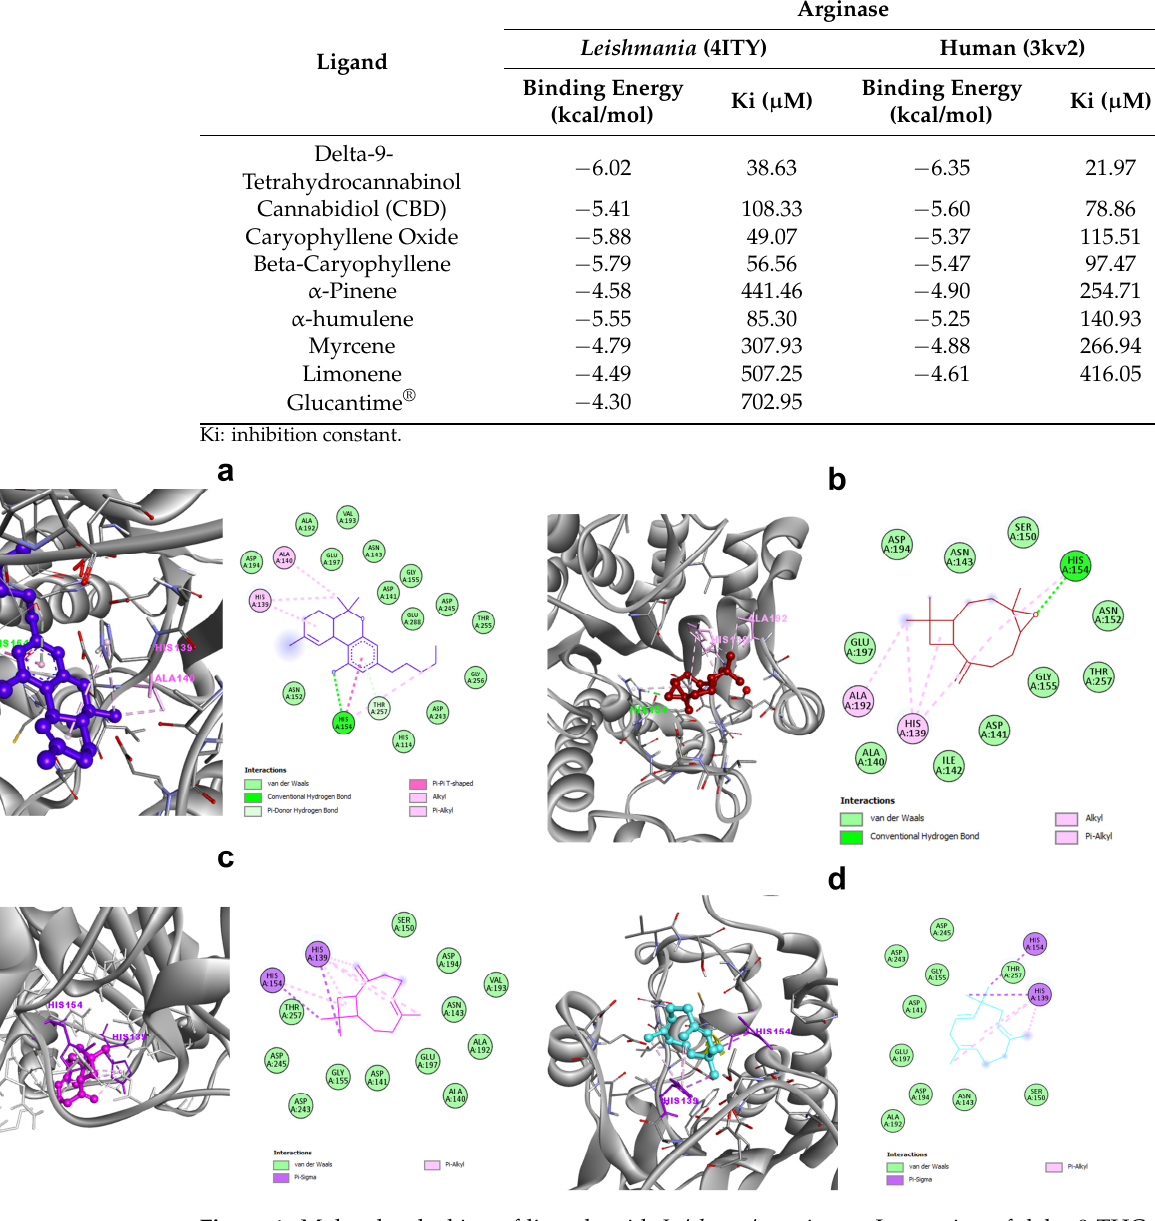
Figure 1. Molecular docking of ligands with Leishmania arginase. Interaction of delta-9-THC ( a ), caryophyllene oxide ( b ), beta-caryophyllene ( c ), and α - humulene ( d ) with the Lm Arg protein and its linked amino acid